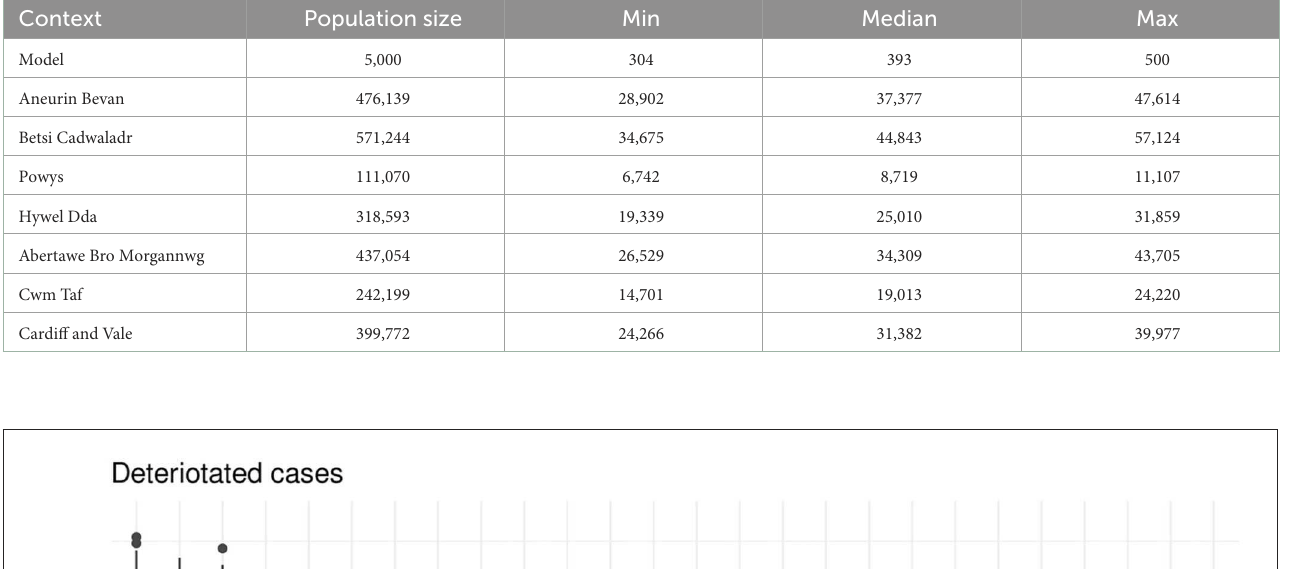
TABLE 3 Depression prevalence projected to population in Wales by LHB.